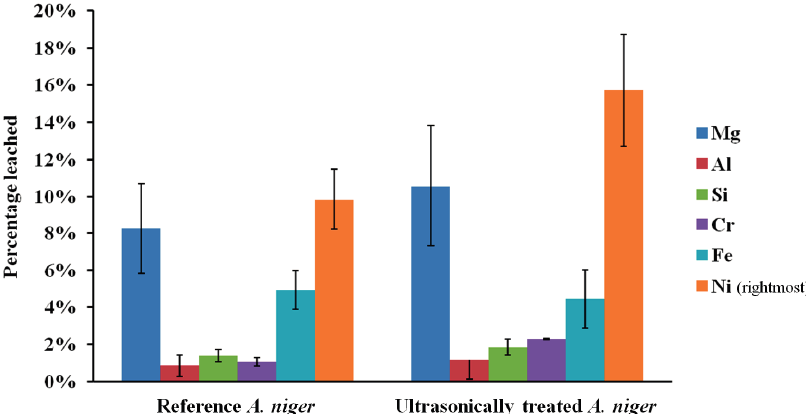
Figure 4. Elemental leaching extent from fresh olivine in untreated and ultrasonically conditioned Aspergillus niger broth over 17 days; error bars indicate range of